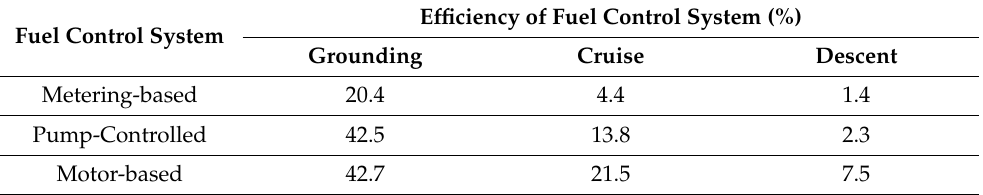
Table 1. Efficiency of fuel flowrate control system under different flight mission conditions.